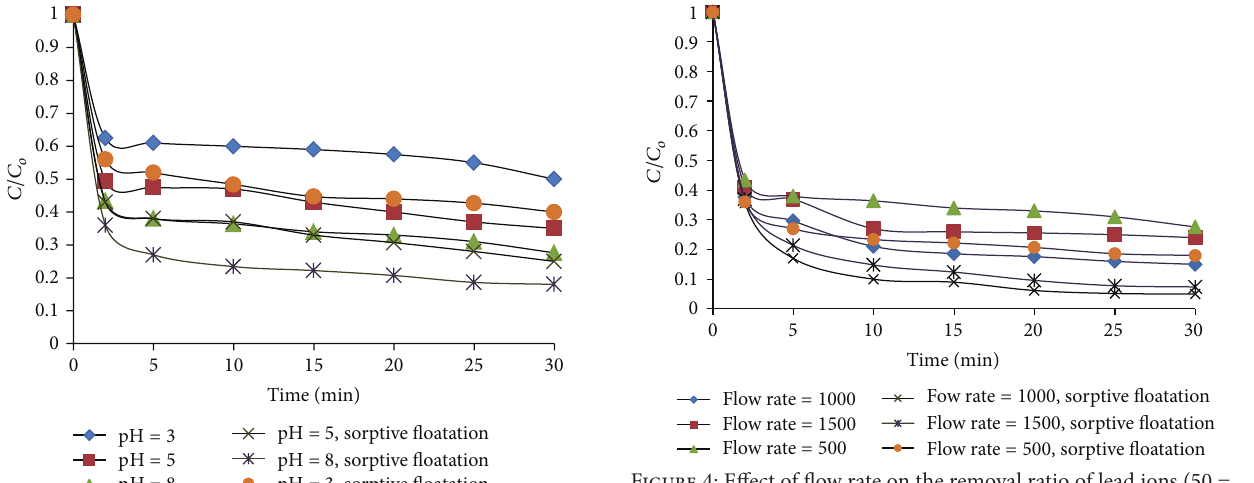
Figure 4: Effect of flow rate on the removal ratio of lead ions (50 = 100mg/L; SDS = 25mg/L barely husk = 20 gm/L).